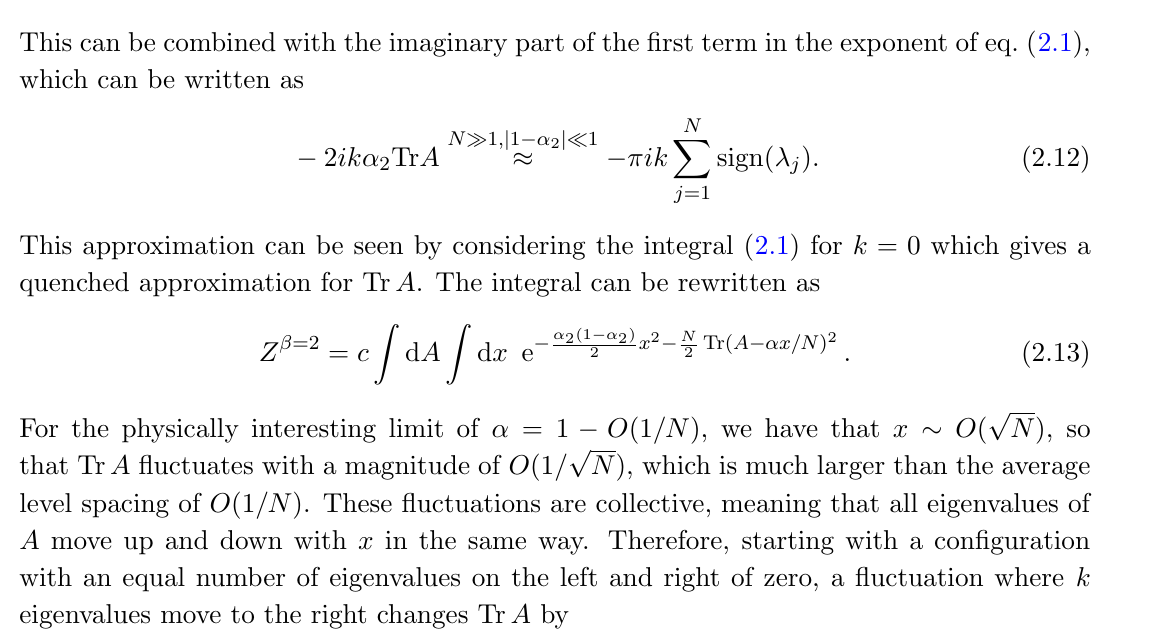
Figure 1 . Distribution (cid:26) sign ( r ) of the ratio r = Tr A= Tr sign( A ) for k = 0 and N f = 0 generated by Monte Carlo simulations. The matrix size N is chosen to be one of the two values N = 100 (bright solid histograms) and N = 1000 (dark dashed histograms) and the parameter (cid:11) 2 = 1 (cid:0) a 2 =N takes e three values with the ratios a 2 =N = 10 (cid:0) 1 (green), a 2 =N = 10 (cid:0) 2 (red), and a 2 =N = 10 (cid:0) 3 (blue). The e e e ensemble size varies because we omitted those con(cid:12)gurations with r = 1 , i.e. Tr sign( A ) = 0. The p number of these con(cid:12)gurations decreases according to a 2 =N . The limit a 2 =N ! 0 (the physical e e case) becomes a Dirac delta distribution at r = (cid:25)= 2 (black vertical line). Since the histograms with (cid:12)xed quotient a 2 =N agree almost perfectly, they are barely distinguishable, we are save to assume e that the plots show the limiting large N